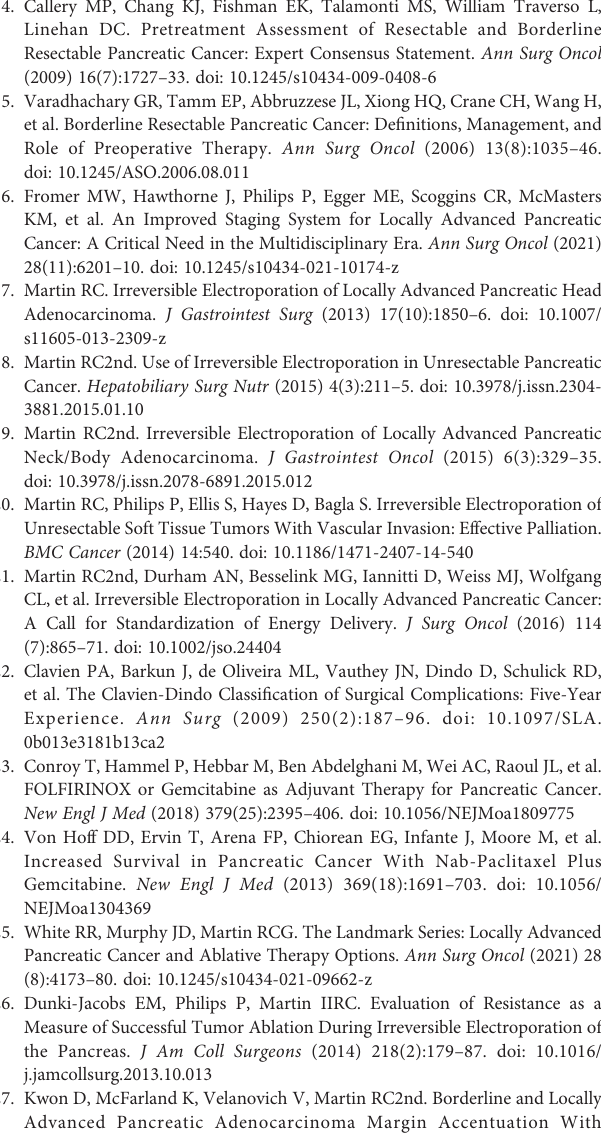
Supplementary Figure 1 | Progression free survival of patients who underwent Pancreatectomy with IRE for margin accentuation versus patients who underwent IRE alone ( In-Situ ) Supplementary Table 1 | Observed adverse